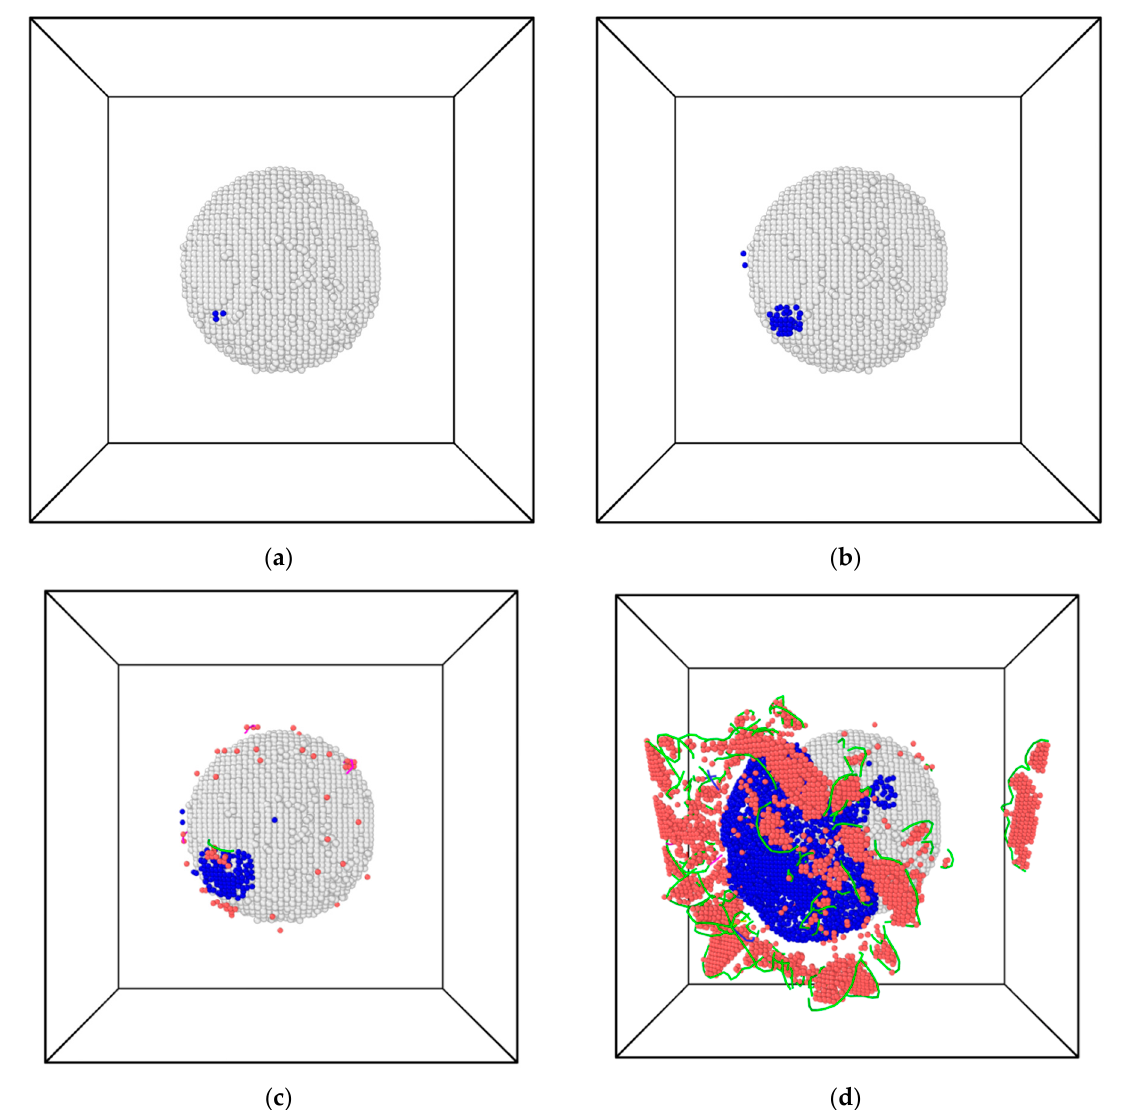
Figure 2. Simulation snapshots from a simulation with T = 400 K and σ H = 6.0 GPa. Blue atoms are associated with a crack (have an atomic volume > 30 Å 3 ). ( a ) Initial appearance of a small crack involving a few atoms at t = 37 ps (relative to the start of the holding stage). ( b ) Subsequent growth of the crack via lattice-trapped delamination at t = 105 ps. ( c ) Initial appearance of dislocations at the crack tips at t = 126 ps. ( d ) Rapid crack growth via dislocation-mediated delamination at t = 139 ps. Green lines are Shockley-Read partial dislocations. Red atoms are associated with stacking faults.